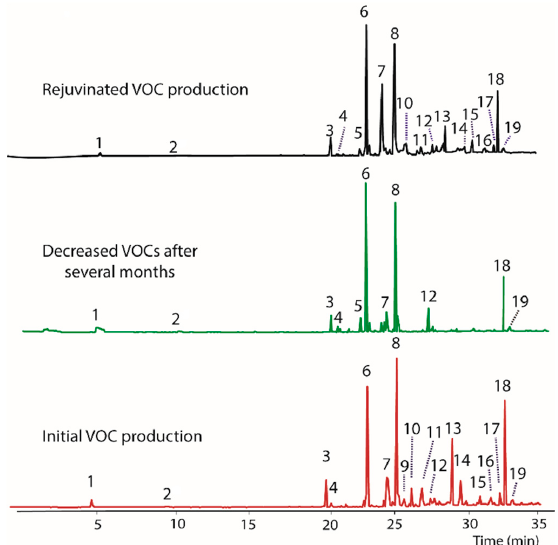
Figure 1. A gas chromatogram illustrating VOCs produced by BS15 showing the original production of VOCs immediately after isolation of BS15 ( bottom ) and decreased production after growing in the lab for several months ( middle ). Nominal mass of each peak and tentative identities are listed in Table 2. Production of VOCs was restored to varying extents ( top ) by growing BS15 on PDA containing finely ground woody tissue from the Taxodium distichum the fungus was originally isolated from. Table 2. A GC/MS analysis of the VOCs produced by BS15. Peak R.T. (min)